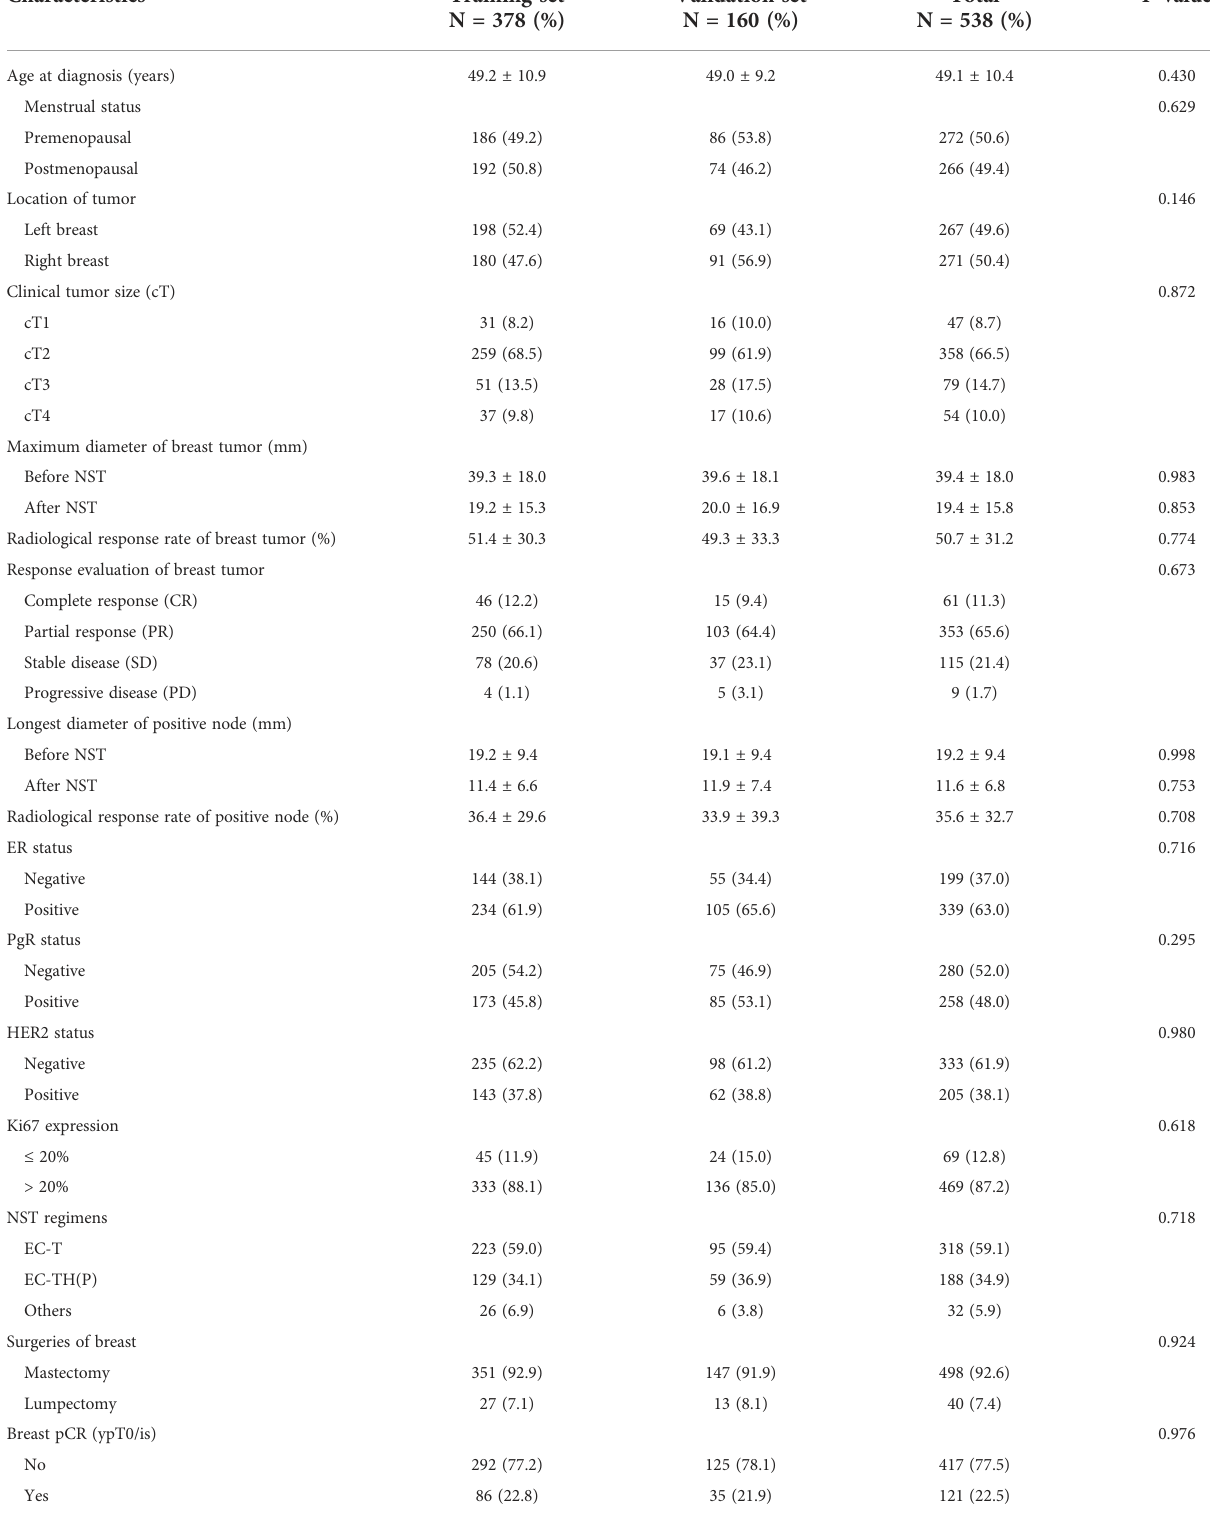
TABLE 1 Characteristics of patients in the training set, validation set and total